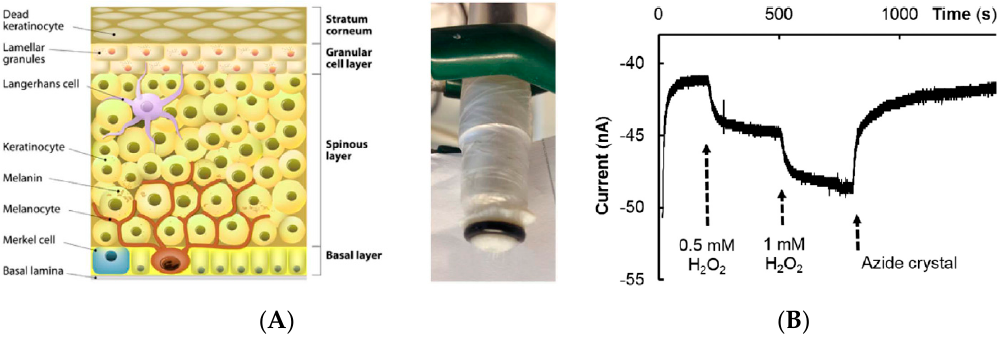
Figure 36. ( A ) (left) Scheme of the whole epidermis; (right) oxygen electrode covered with viable pig skin, used in this study. ( B ) Current delivered by the skin-covered oxygen electrode when immersed in phosphate buffer saline + sequential H 2 O 2 addition. The catalase enzyme contained in the skin transforms H 2 O 2 into O 2 , which diffuses back to the electrode. Azide, as catalase inhibitor, is added to attest that the current is due to the enzyme activity. Reproduced from [100] with permission. © 2017